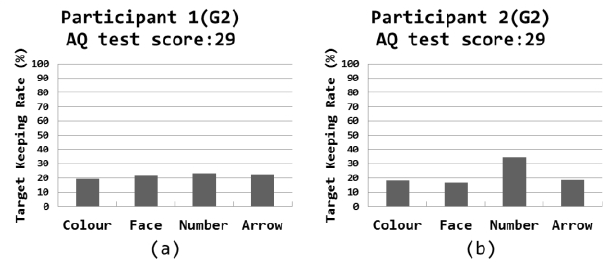
4.1.2. Group 2: a borderline of autism (AQ score = 26 – 31) The participants from Group 2 (Participant 1(G2), female and Partici- pant 2(G2), male; both with AQ score 29) demonstrated a sustainable TKR for all tasks while achieving a TKR that was a little higher for the task with numbers. The individual results of the participants are pre- sented in Fig. 8 (a) and Fig. 8 (b) respectively.